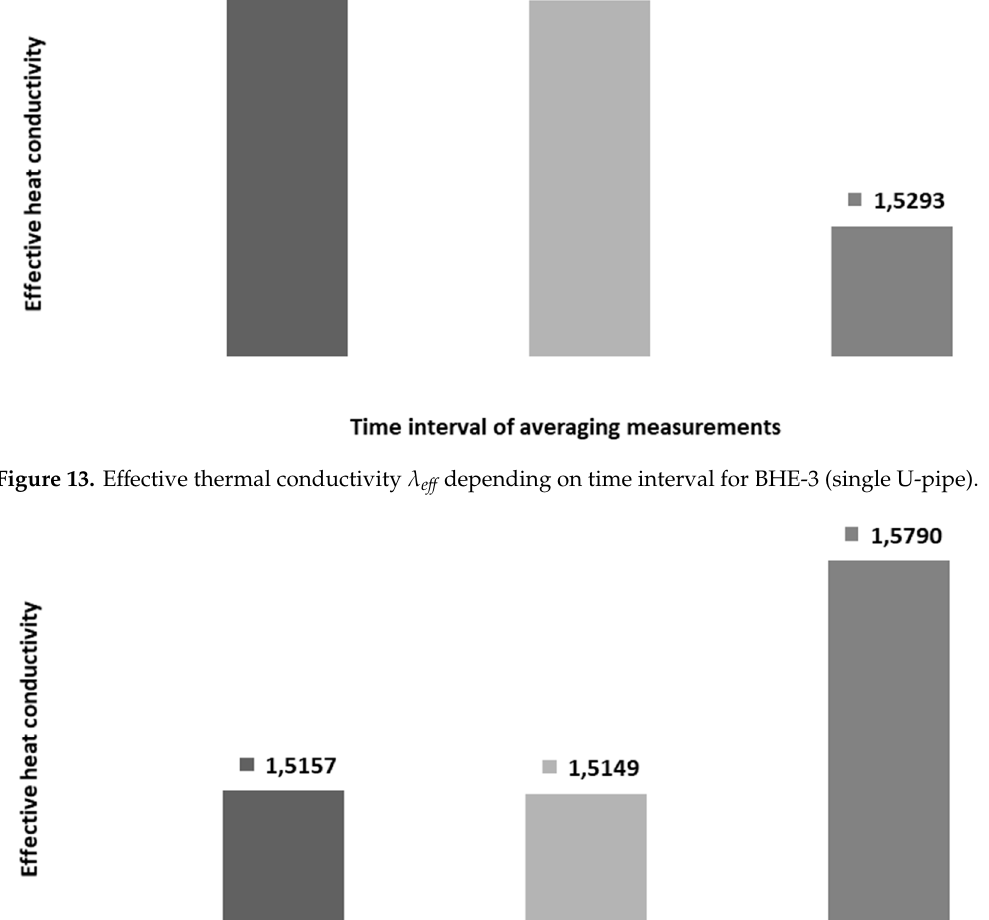
Figure 14. Effective thermal conductivity λ eff depending on time interval for BHE-5 (double U-pipe).